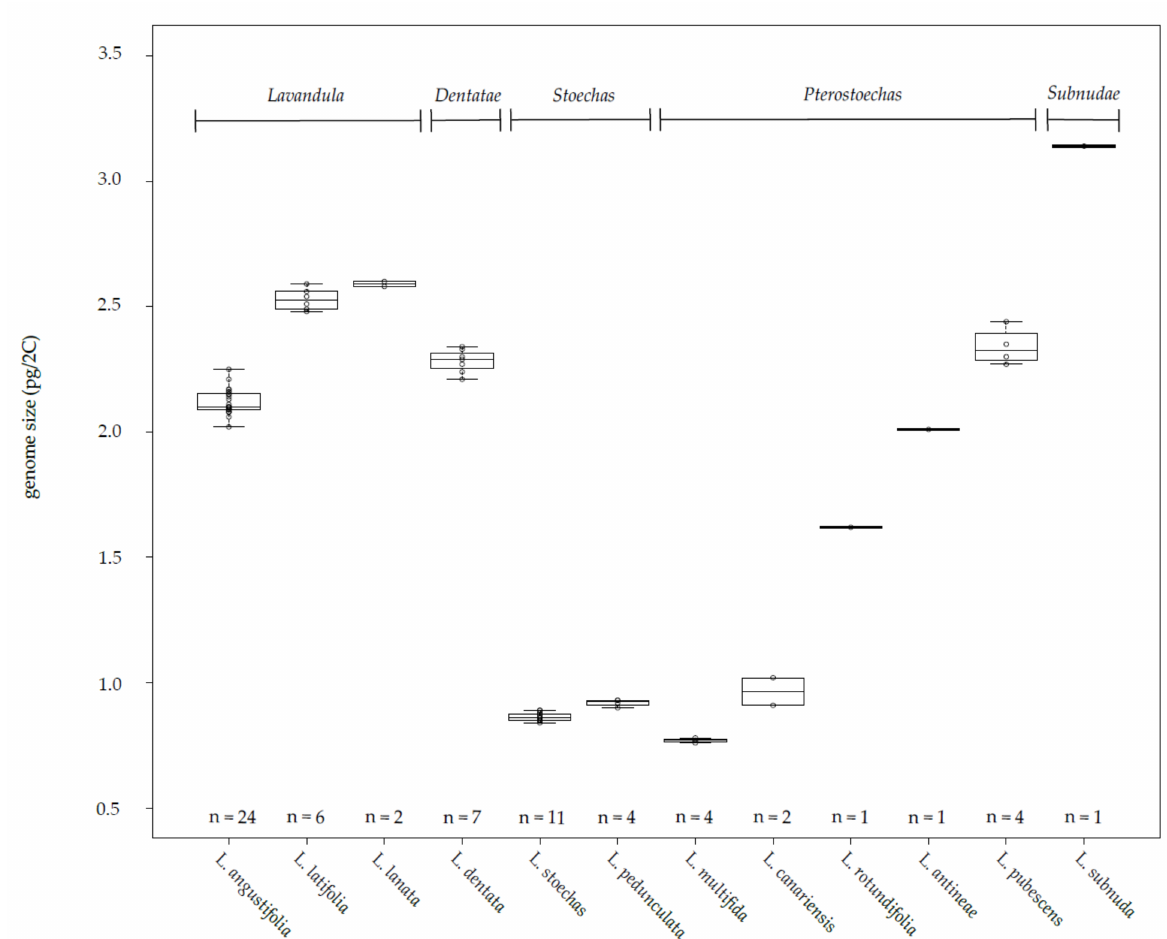
Figure 2. Boxplot of genome sizes (2C values) for 12 Lavandula species. Individual data points and number of genotypes analyzed per species ( n =) are shown. The median genome size value for every species is represented by the line in every box. Sections of the genus Lavandula are shown above the